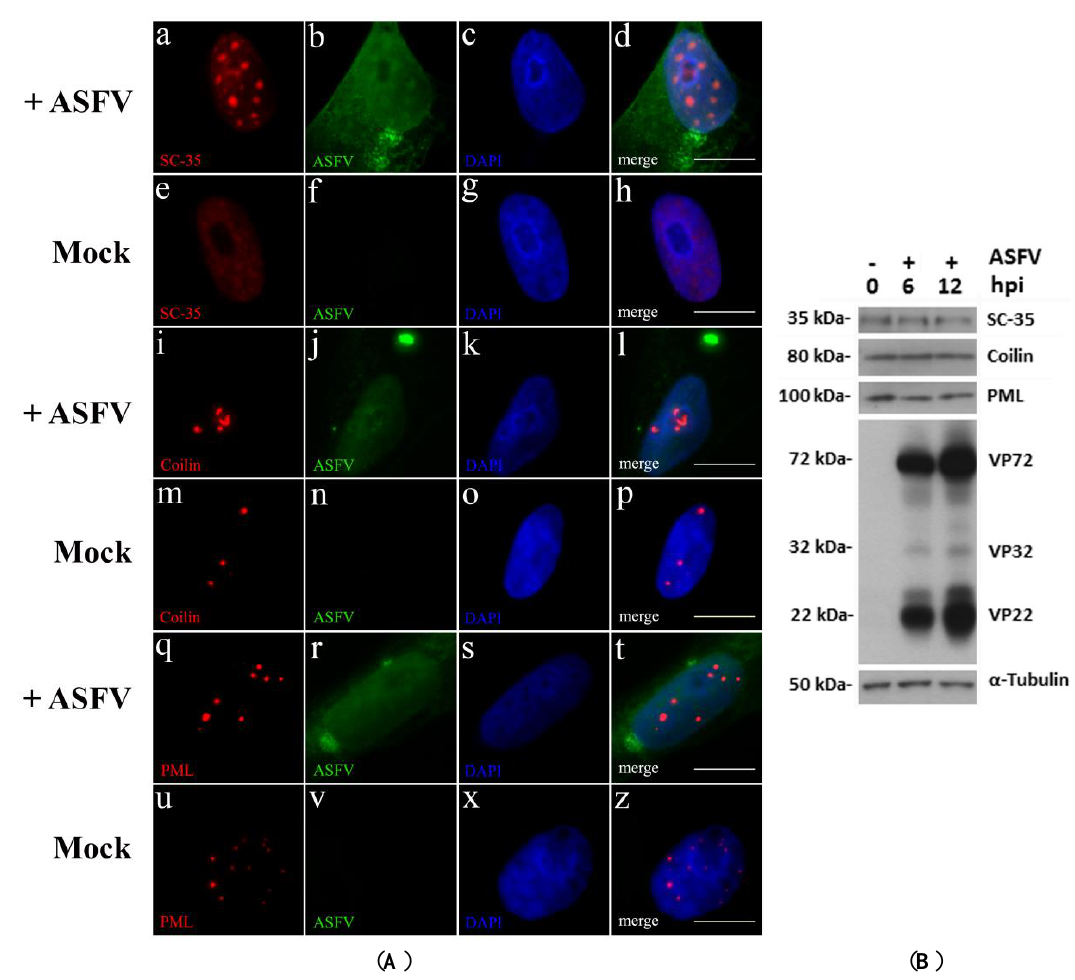
Figure 1. ( A ) ASFV induces the reorganization of subnuclear domains. Vero cells were infected with ASFV Ba71V isolate (MOI of 5), fixed at 6 hpi, permeabilized and immunostained; cell nuclei stained with DAPI (blue). ( a – d ) ASFV-infected cells (green) reveal globular and enlarged accumulations of SC-35 (red), while in non-infected cells ( e – h ), nuclear speckles (SC-35) show a pan-nuclear staining. ( i – l ) In ASFV-infected Vero cells (green), Cajal bodies (coilin, red) display “comma-shaped” morphology and group together, contrasting with the few pin-point bright foci of non-infected cells ( m – p ). ( q – t ) PML-NBs (PML, red) of infected cells (green) reveal fewer and enlarged domains, when compared to non-infected cells which show an increased number of smaller dots ( u – z ). Scale bar, 10 µ m. Representative images of at least three independent experiments are shown; ( B ) Protein levels of SC-35, coilin and PML remain constant during ASFV infection. Vero cells infected with ASFV Ba71V isolate were lysed at 6 and 12 hpi, and compared to mock-infected cells, using immunoblotting analysis. α -Tubulin was used as loading control. Molecular weights (kDa) of evaluated proteins are indicated on the left of immunoblot images.